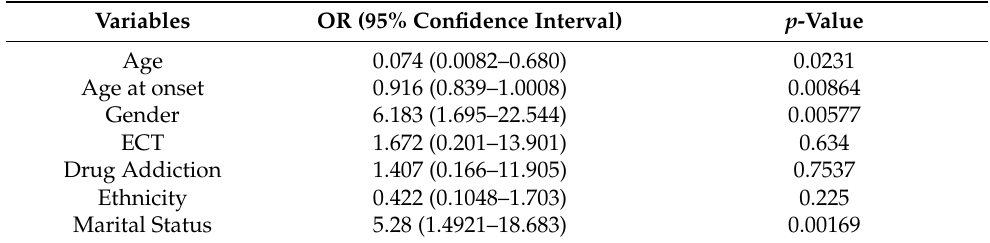
Table 3. Multivariate regression model to show association between family history of schizophre- nia and sociodemographic parameters. Table 2. Association between medication response and other variables in the generalized linear regression model.